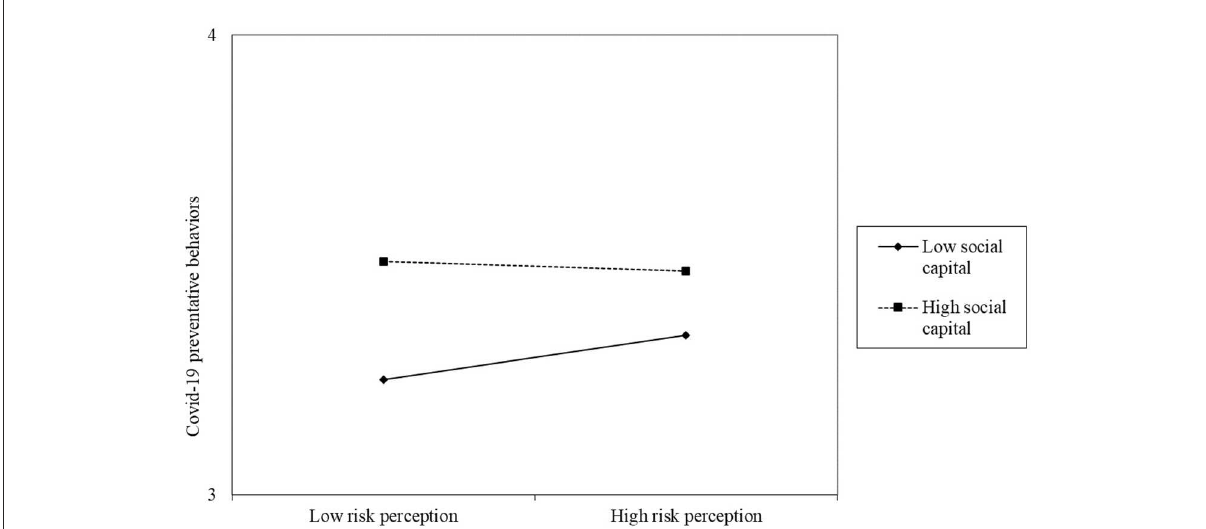
FIGURE1 The moderating effects of social capital on the relationship between flood risk perception and COVID-19 preventive behaviors.